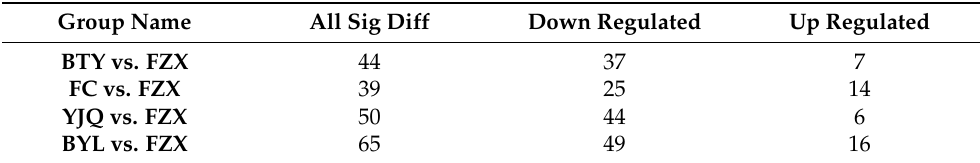
Table 1. Statistical table of the number of metabolites of different litchi cultivars in different maturity.